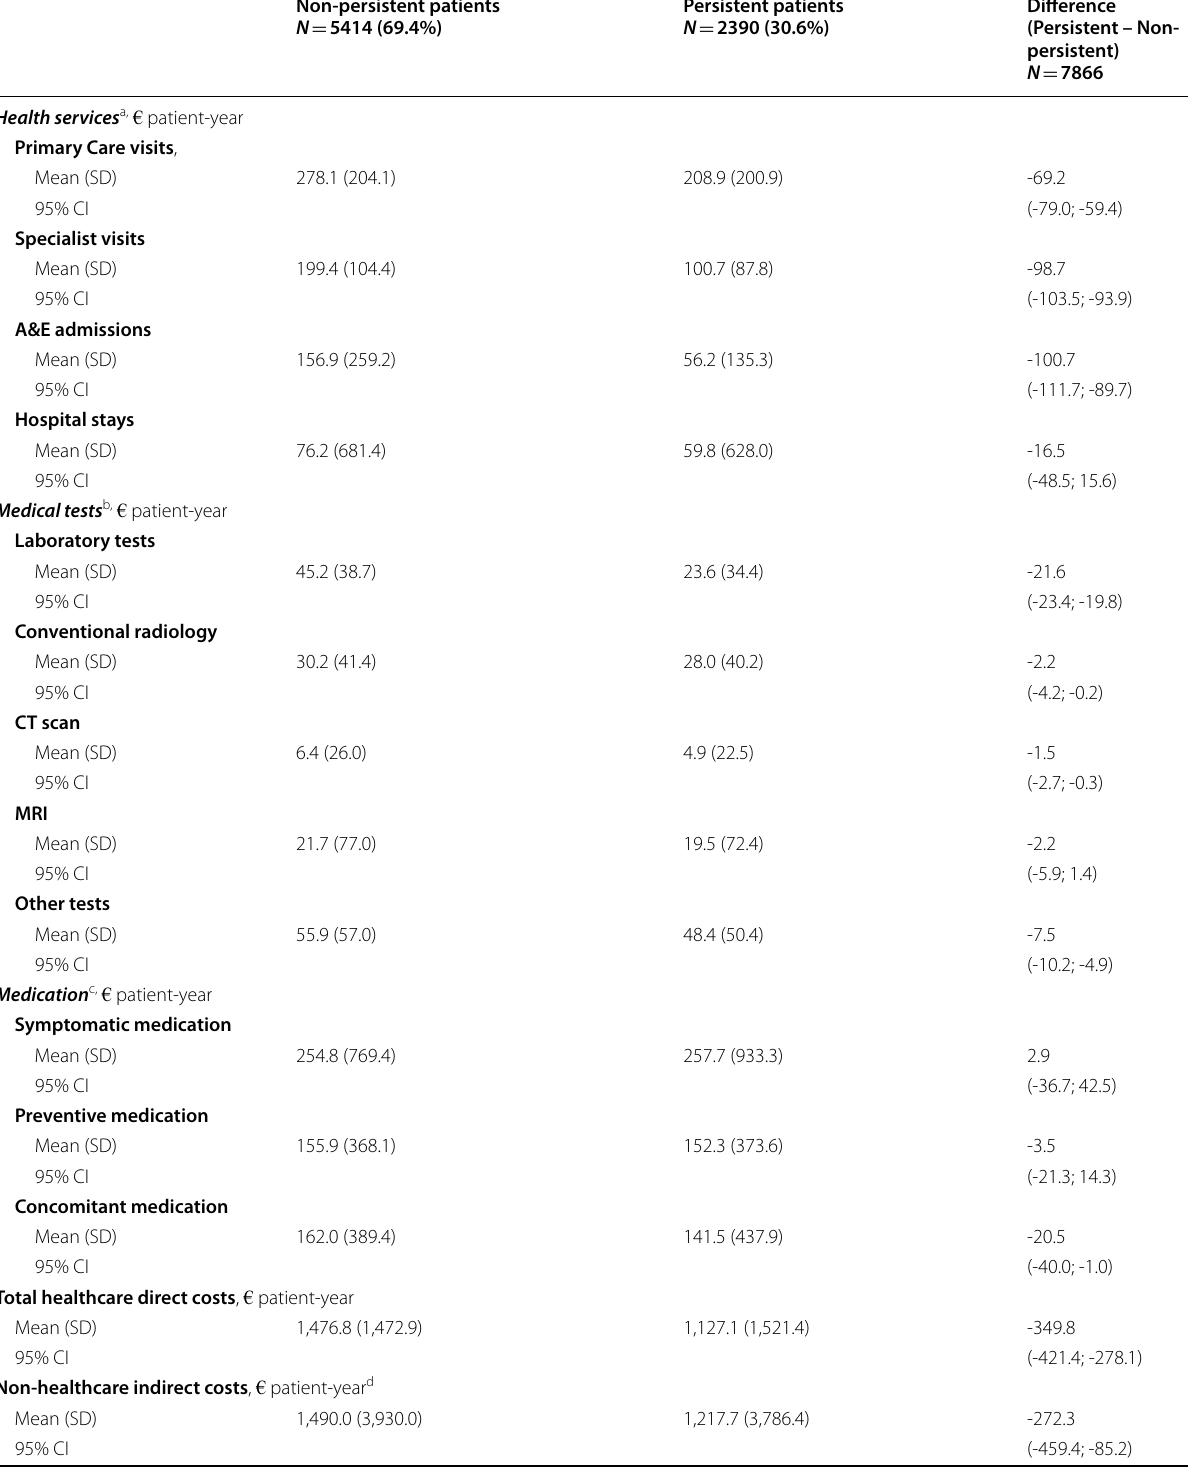
Table 4 Annual healthcare and non‑healthcare costs associated with migraine patient management and preventive treatment